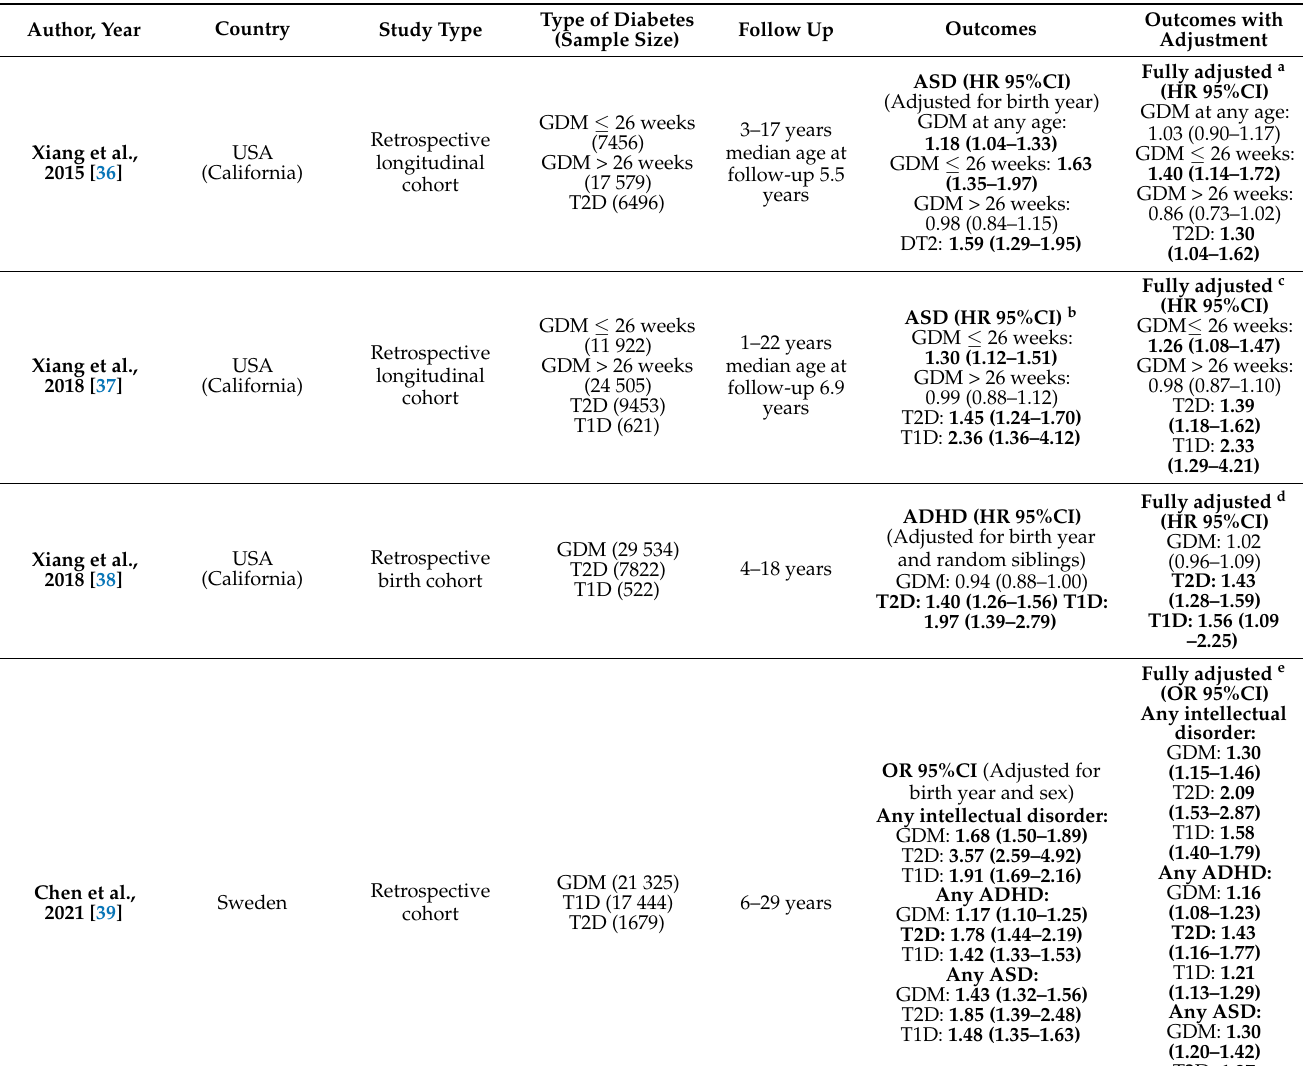
Table 5. Risk for neurodevelopmental outcomes including intellectual disorder, autism disorder (ASD) and attention deficit hyperactivity disorder (ADHD). GDM: gestational diabetes mellitus; T1D: type 1 diabetes; T2D: type 2 diabetes; OR: odds ratio, HR: hazard ratio. Significant results are in bold ( p <